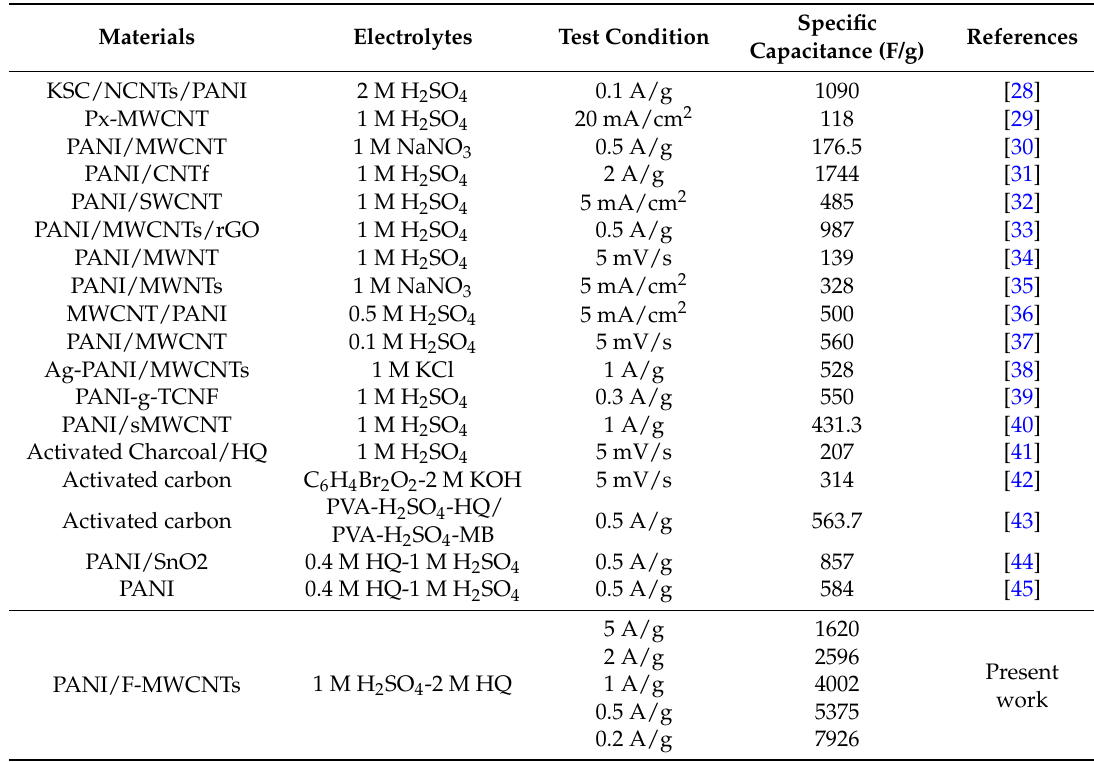
Table 1. Comparison of specific capacitance between the system of our present works and the reported